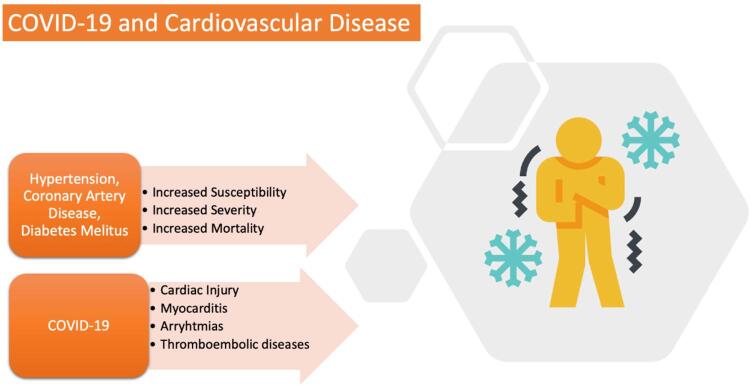
– Interaction between cardiovascular diseases/risk factors and COVID-19. Cardiovascular comorbidities such as hypertension and coronary artery disease are associated with increased susceptibility and higher mortality in patients with COVID-19. COVID-19 is also associated with cardiovascular manifestations including myocardial injury, myocarditis, arrhythmias, acute coronary syndrome and thromboembolism.